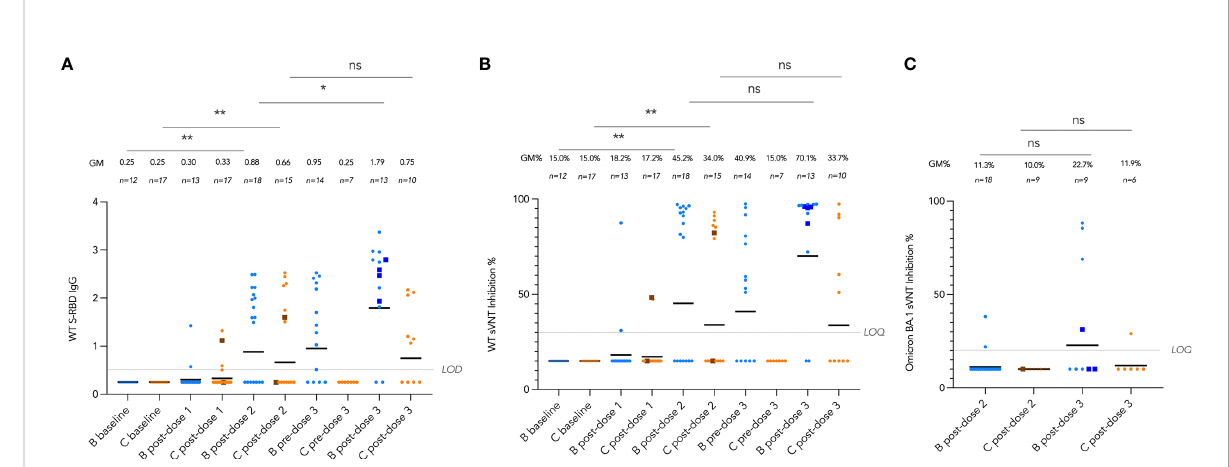
FIGURE 4 Longitudinal analysis of (A) , wild-type (WT) Spike-receptor binding domain (S-RBD) IgG, (B) , WT surrogate virus neutralization test (sVNT) results, and (C) , Omicron BA.1 sVNT by vaccine brand. Geometric means (GM) are shown with center lines and stated above each column. Limits of detection and quanti fi cation (LOD and LOQ) and cut-offs were drawn as grey lines. Data from participants receiving intradermal vaccination were shown as darkened squares beginning at their initial intradermal dose. Data from the same participant were analyzed longitudinally by paired t test after natural logarithmic transformation, and the P values are denoted by asterisks (*, P<0.05; **, P<0.01; ns, not signi fi cant).